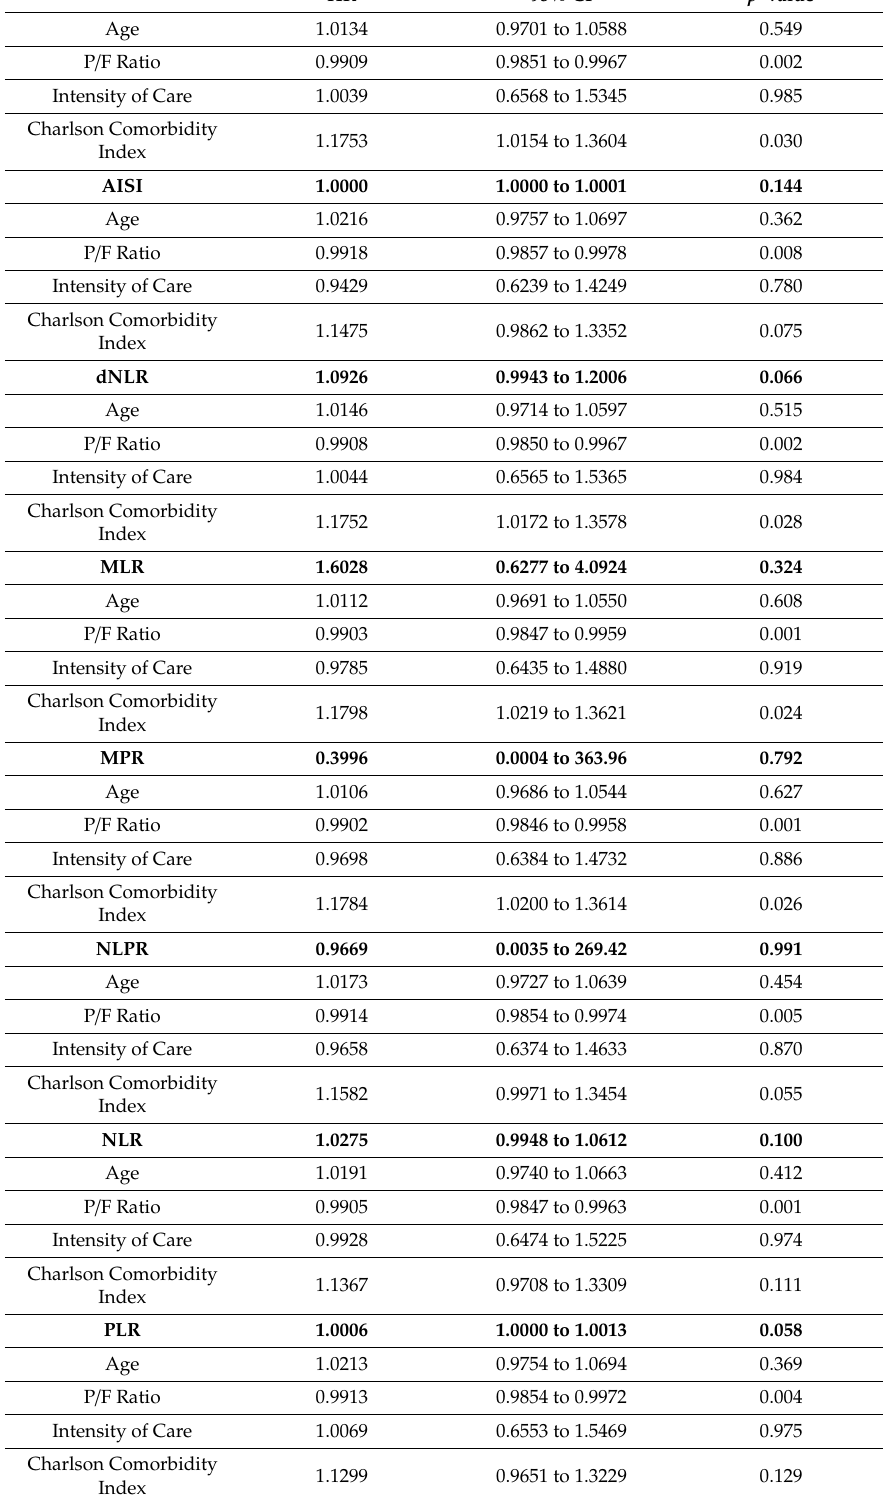
Table 4. Hazard ratios of the indexes under investigation obtained by Cox regression